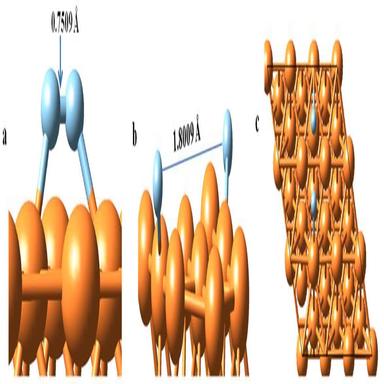
(a) Initial model of H2 molecule on the Ni (111) surface, (b) side view and (c) top view after optimization.